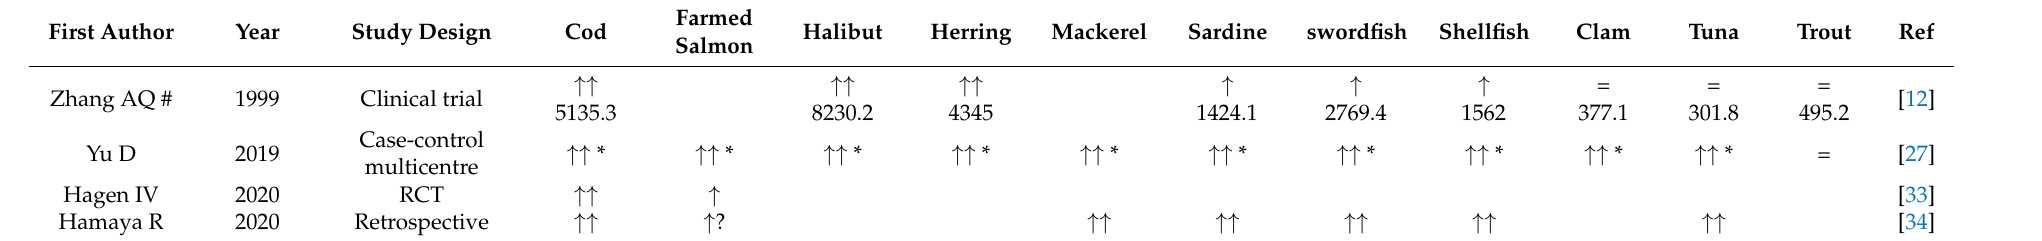
Table 2. Associations of different types of fish intake with